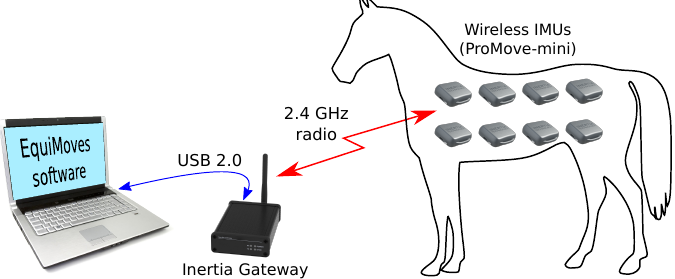
Figure 5. System overview. IMU: inertial measurement unit.